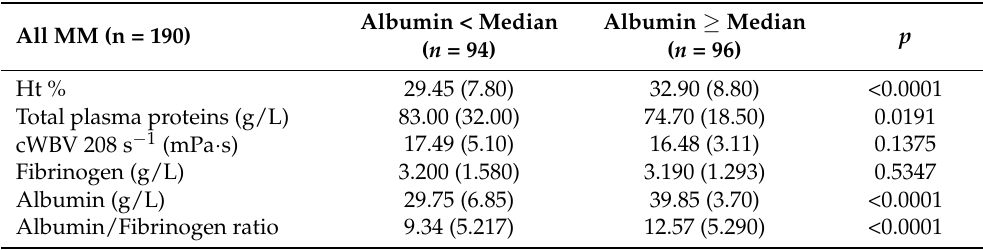
Table 5. Medians (IQR) of hemorheological determinants in all MM patients subdivided according to the median of